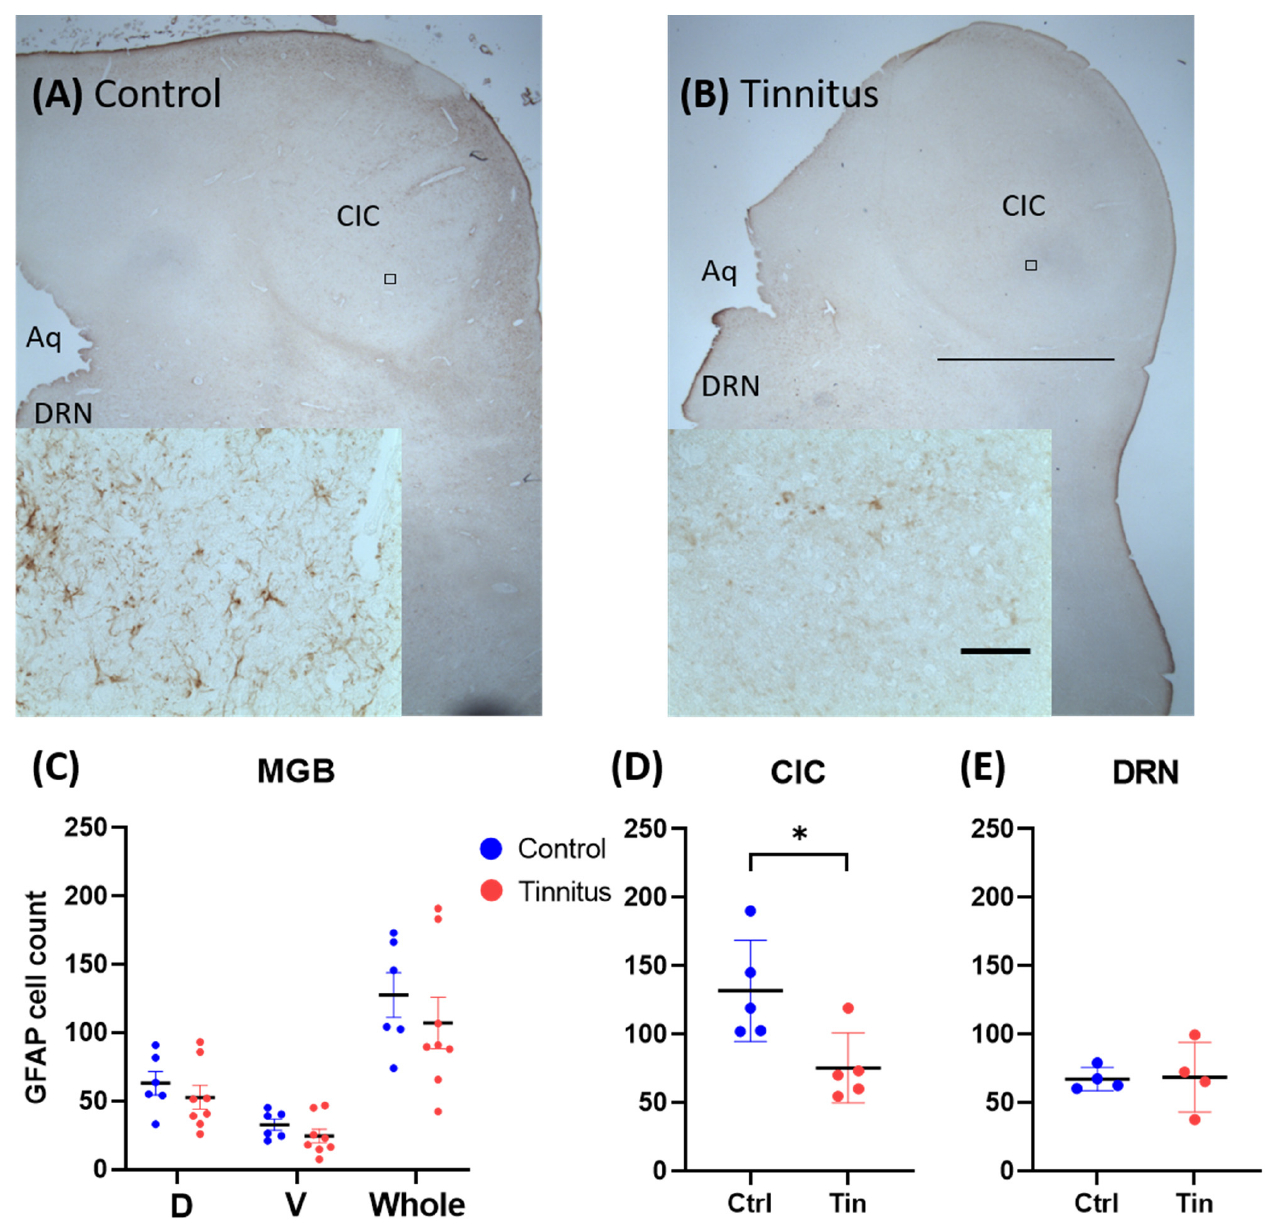
Figure 3. Glial fibrillary acidic protein (GFAP) expression in the MGB, CIC, and DRN. ( A , B ) Repre- sentative low-power and high-power photomicrographs inset in the left corner for control subject and tinnitus, respectively. ( C – E ) Cumulative data showing the means and SEMs of GFAP cell count in tinnitus and control groups. ( C ) Graph shows the number of GFAP-positive cells in (D) dorsal and (V) ventral and (whole) MGB. p value < 0.05 was defined as significant level and is indicated by a (*). Note the significant reduction in GFAP cell count in the CIC only. Scale bar = 2 mm; scale bar in the inset = 50 µ m. Aq, cerebral aqueduct; CIC, central part of inferior colliculus; DRN, dorsal raphe nucleus; and MGB, medial geniculate body.